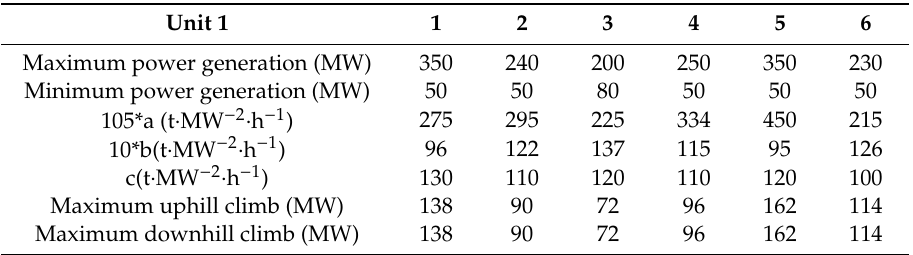
Table 1. Parameters of the thermal power